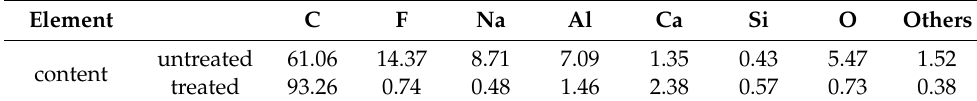
Table 1. Ultimate analysis of untreated and alkali-fused SCC/%.